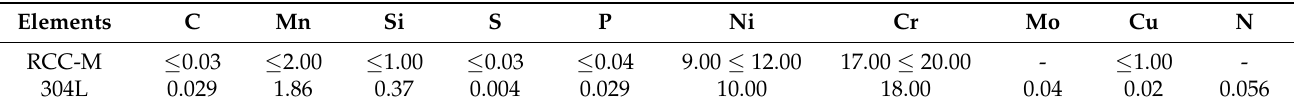
Table 2. Chemical composition of 304L austenitic stainless steel (on product) and a comparison with the RCC-M 3307 specification (weight percentage).